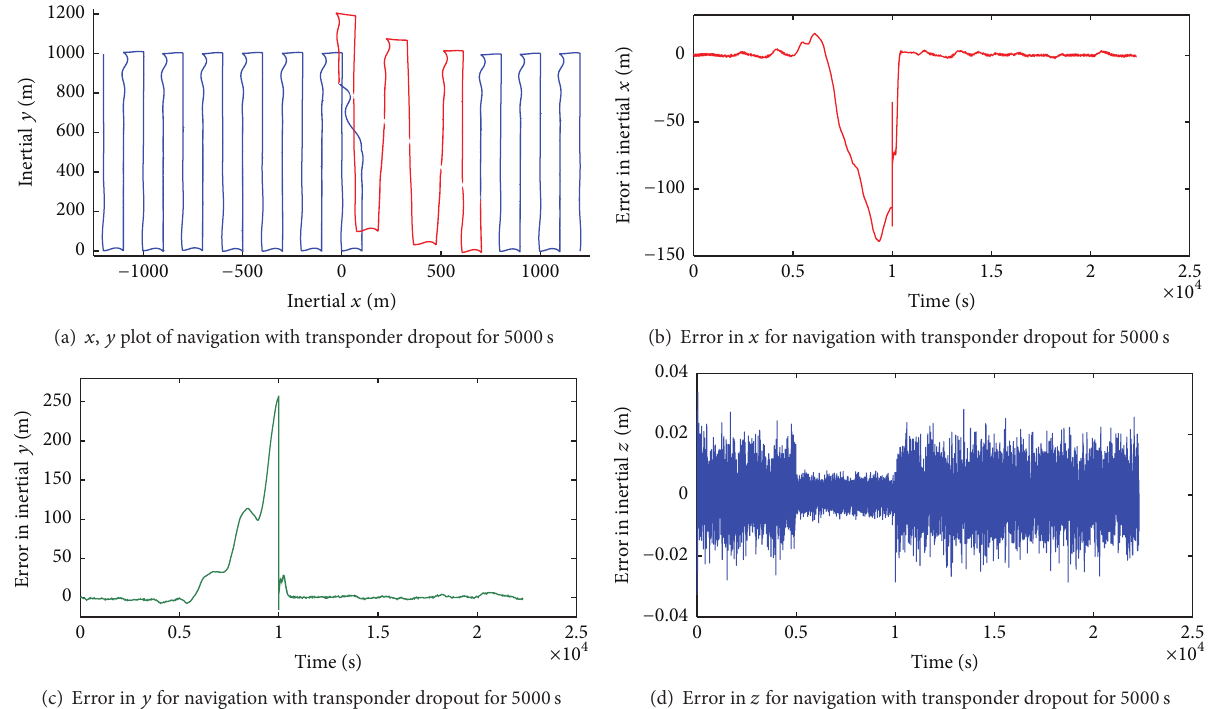
Figure 9: Navigation with a transponder dropout and no velocity aiding for 5000